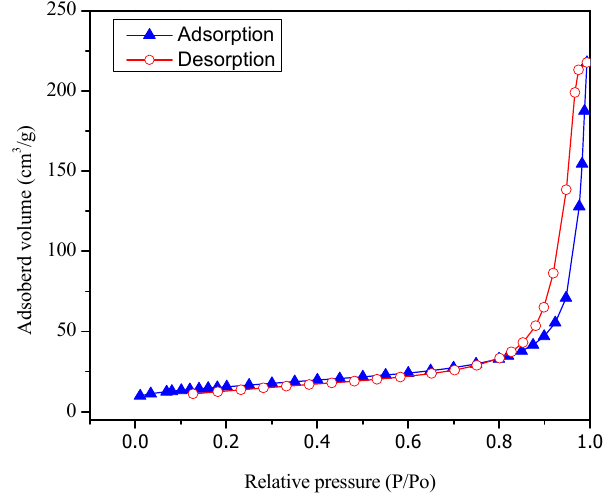
Figure 3. Adsorption–desorption isotherms for Pt- TiO 2 . Pt was added by wet impregnation.